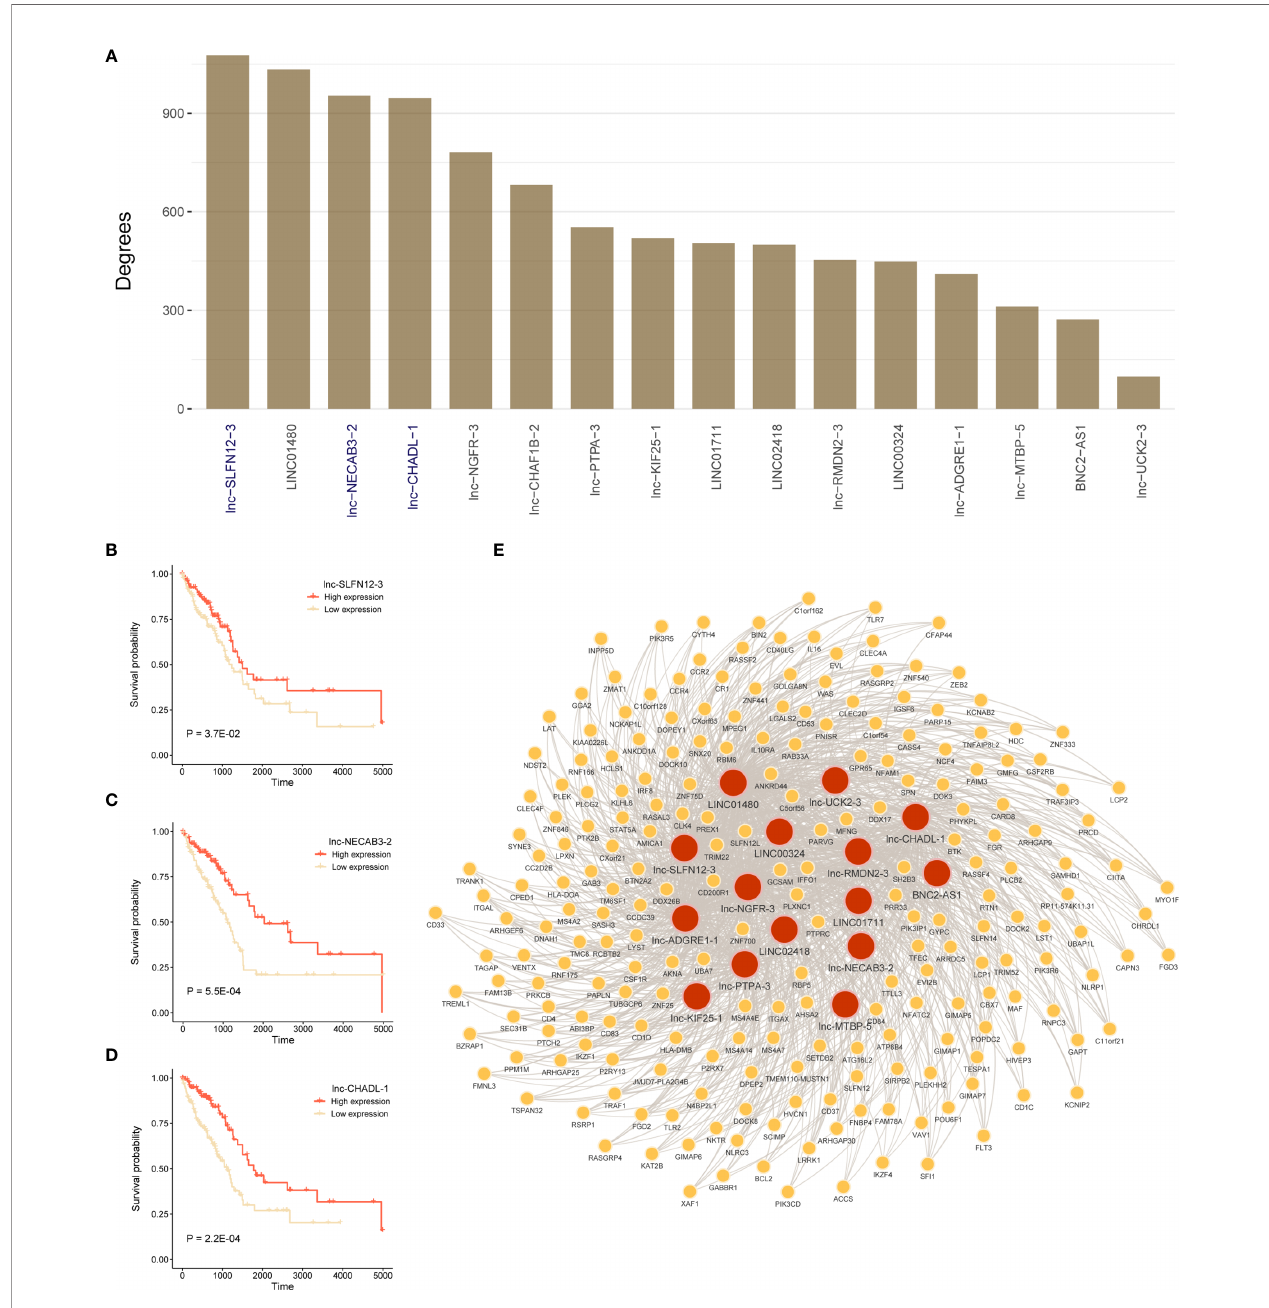
FIGURE 7 | Construct lncRNA-mRNA co-expression network and survival analysis for hub lncRNAs. (A) Degrees of 16-lncRNAs in lncRNA-mRNA co-expression network. (B – D) Log-rank test was used to assess the difference in OS between lnc-SLFN12-3, lnc-NECAB3-2, or lnc-CHADL-1 high expression and low expression samples in TCGA LUAD training cohort. (E) Signi fi cant co-expression network between 16-lncRNAs and 225 mRNAs (keep signi fi cant co-expression relationships more than quarter 16-lncRNAs). Red nodes mean lncRNAs, and yellow nodes mean mRNAs. The width of the edge represents the Pearson